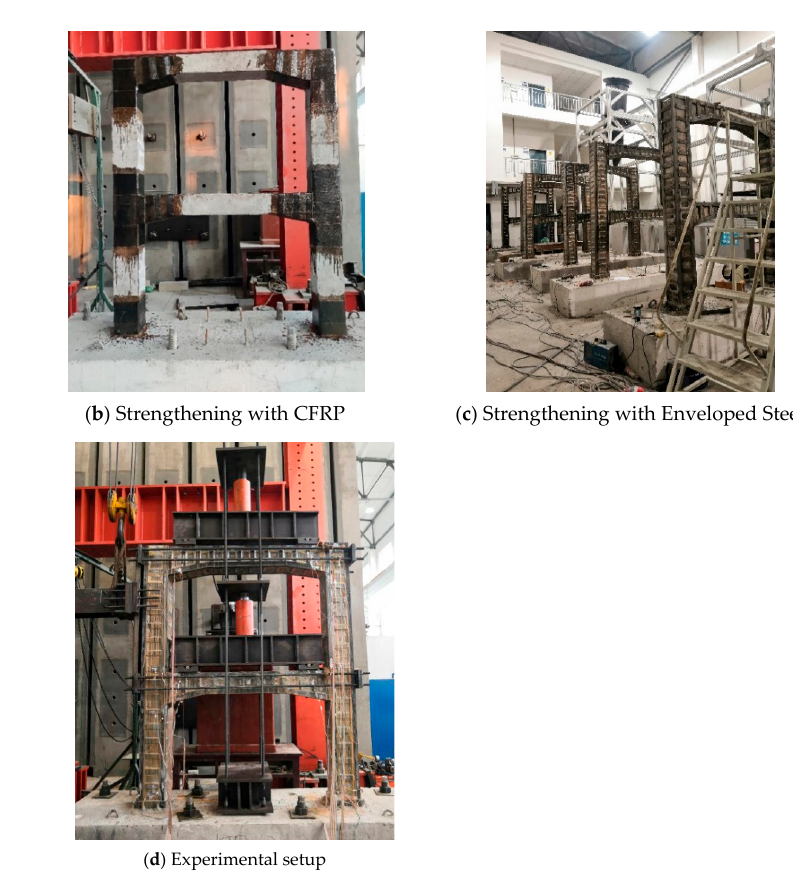
Figure 5. Reinforcement design of specimens.